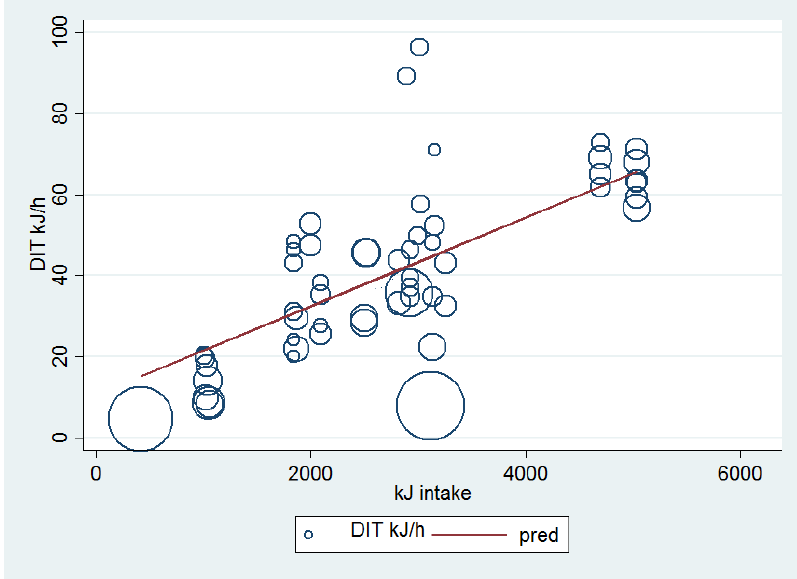
Figure 2. Mixed Model Meta Regression: univariate association between energy intake (kJ) and DIT (kJ/h) (Model 1). The Figure is composed of circles and a regression prediction line (in red) representing the outcome (DIT); each circle represents the value of DIT (kJ/h) for an arm of a study, and the size of the circle is inversely proportional to the standard error (SE) of the study. The influence of each